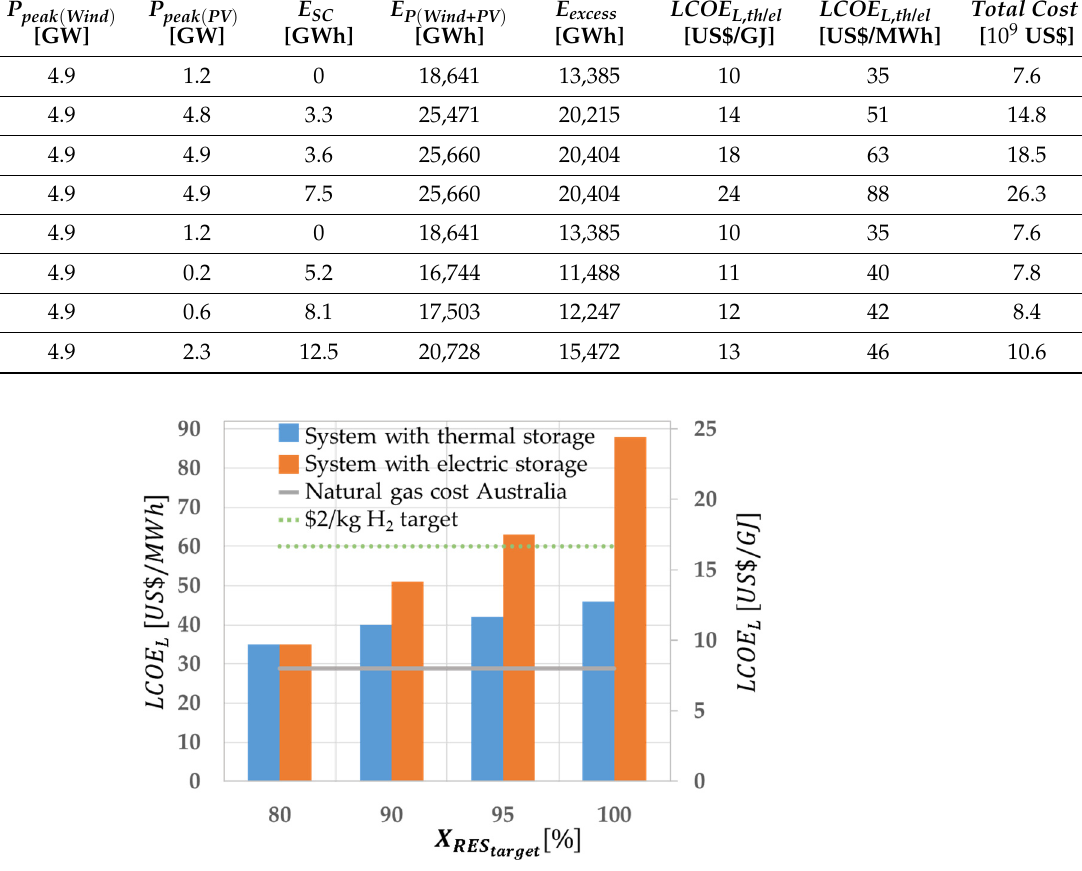
defined in Equation (2) for target (cid:3295)(cid:3276)(cid:3293)(cid:3282)(cid:3280)(cid:3295)